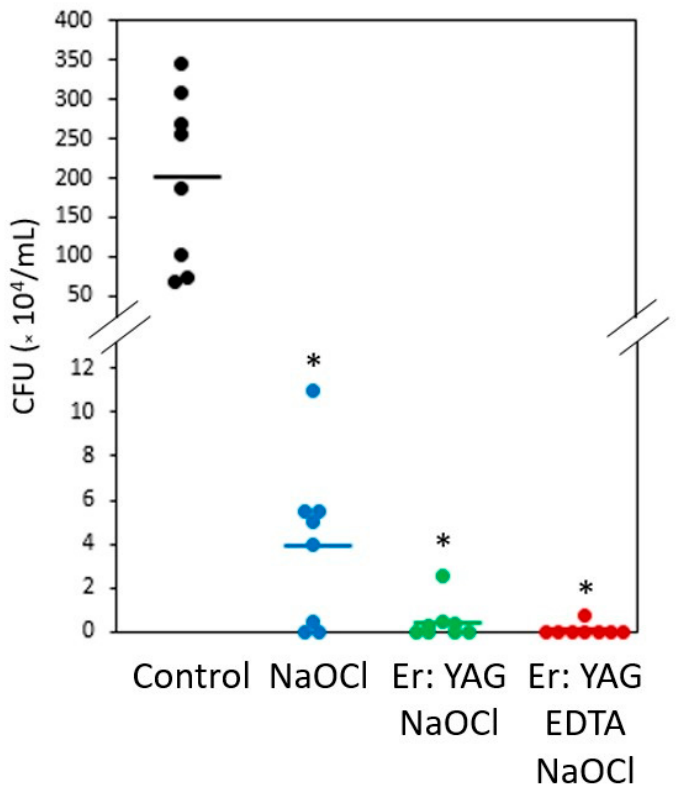
Figure 2. Comparison of the anti-bacterial effect of Er:YAG laser–Endo tip alone or combined with 2.5% NaOCl. The number of E. faecalis colonies (×10 4 CFU/mL) observed 24 h after treatment of the infected teeth using the following protocols: Group 1: The CFU of E. faecalis in the tooth root canal without treatment (Control; black). Group 2: The CFU of E. faecalis after 2.5% NaOCl irrigation (blue). Group 4: The CFU of E. faecalis after treatment with the Er:YAG laser-Endo tip combined with 2.5% NaOCl irrigation (green). Group 8: The CFU of E. faecalis after treatment with the Er:YAG laser-Endo tip combined with 17% EDTA irrigation and 2.5% NaOCl irrigation (red). N = 8 in each group. * p < 0.01 for treated samples compared to control. p < 0.02 for Er:YAG with NaOCl versus NaOCl alone. No significant difference ( p = 0.28) between Er:YAG with NaOCl and Er:YAG with NaOCl and